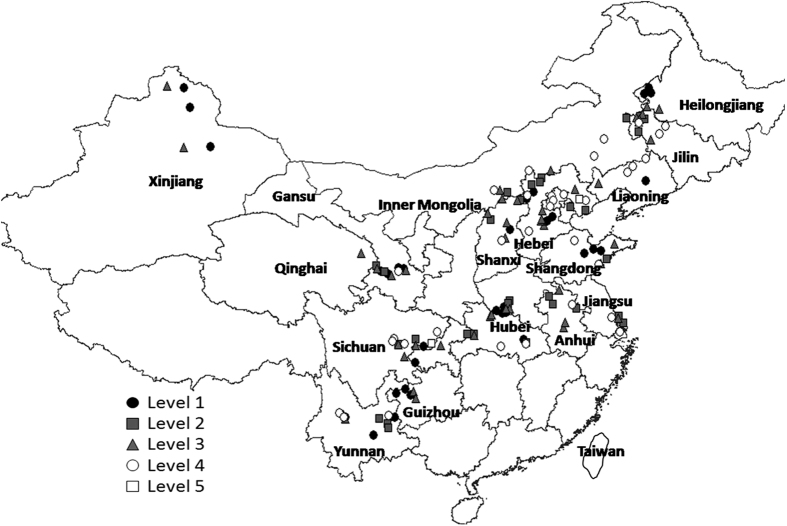
Map of classification of soil available potassium (AK) in food legumes growing areas, Greater China.Created by DIVA_GIS (v7.5) software. Hijmans, R.J., Guarino, L., Mathur P. DIVA-GIS. Version. 7.5.
http://www.diva-gis.org/ (2012) Data of access: 05/07/2015.